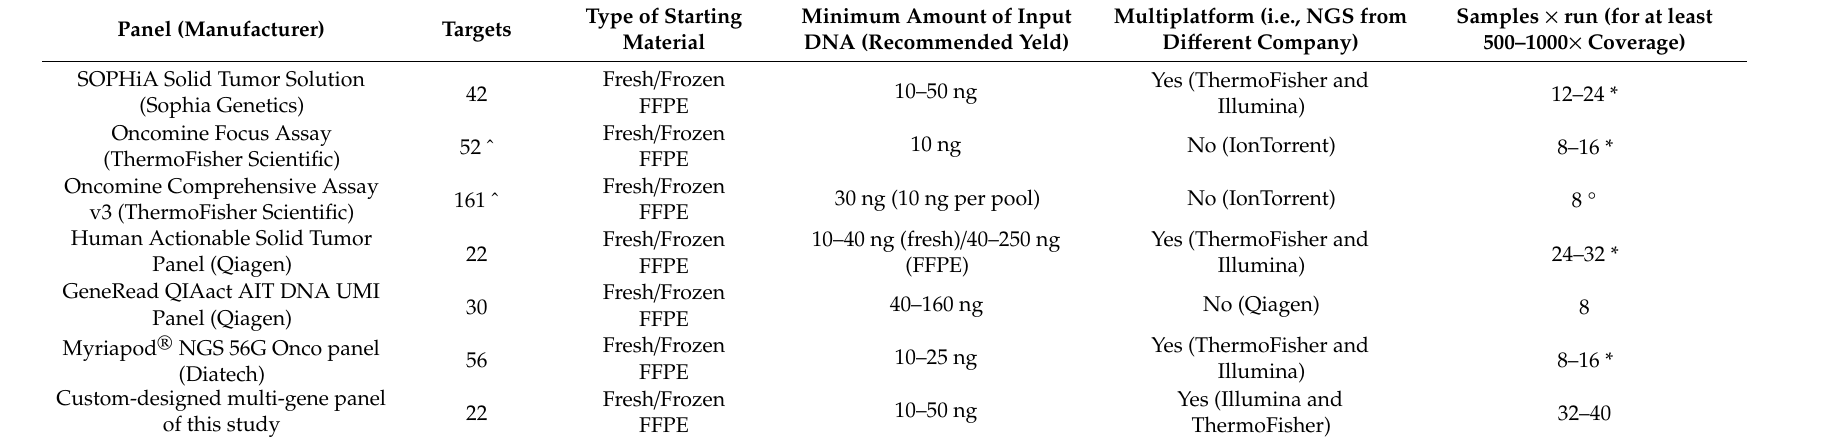
Table 6. Comparison of commercial NGS panel with our custom-designed multi-gene